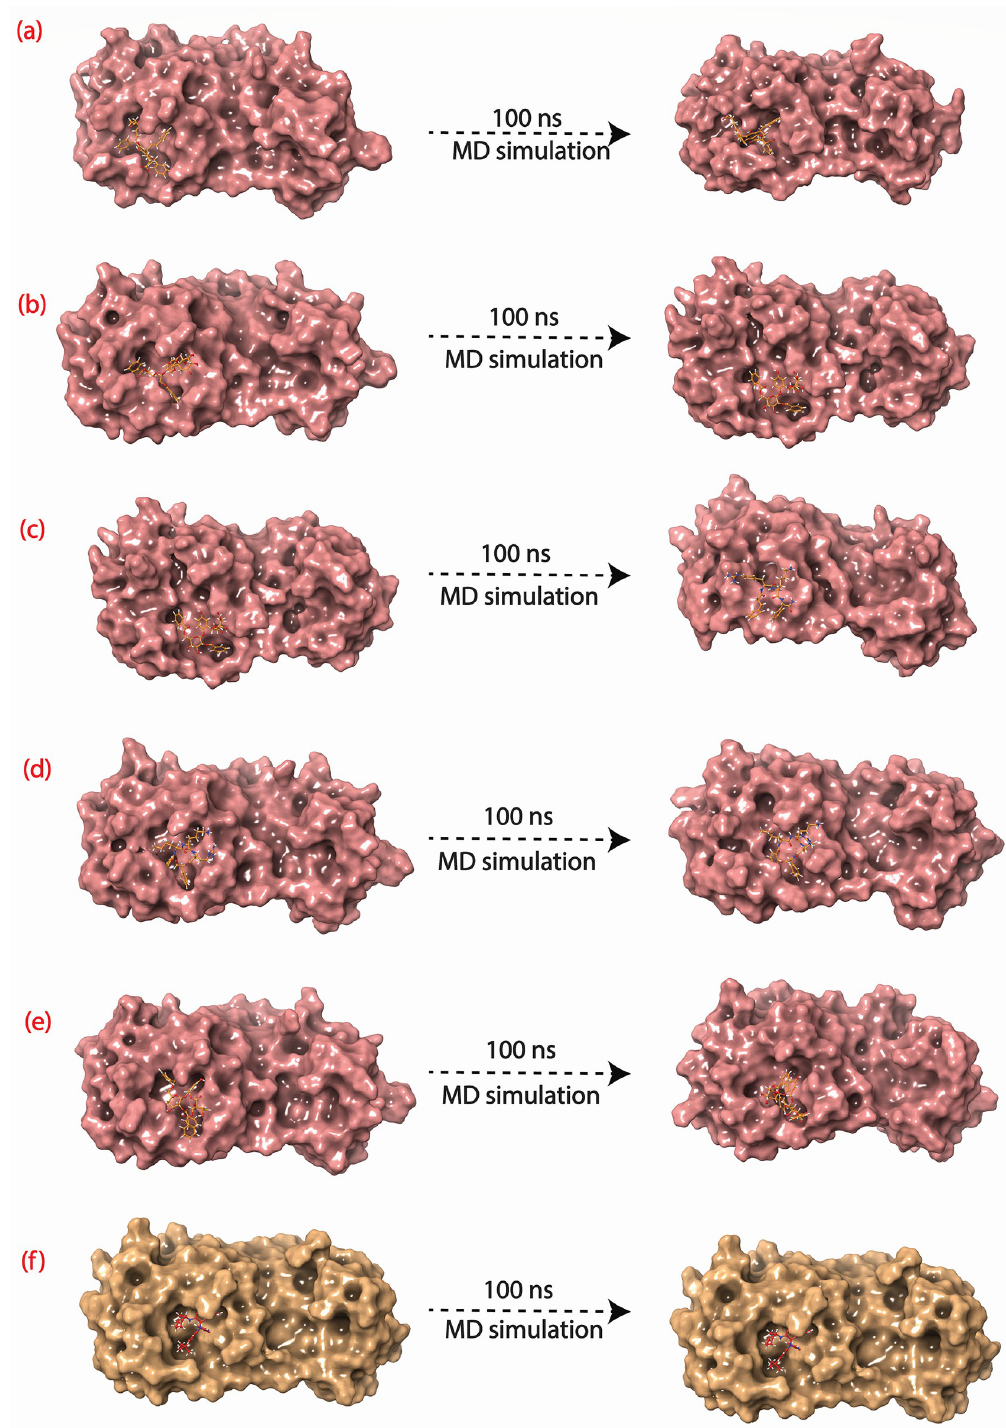
Fig 6. Dynamic flexibility depiction using first and last pose obtained from MD simulation for (a) M pro -CHEMBL1940602 (b) M pro -CHEMBL2036486 (c) M pro -CHEMBL3628485 (d) M pro -CHEMBL200972 (e) M pro -CHEMBL2036488, and (f) M pro -X77